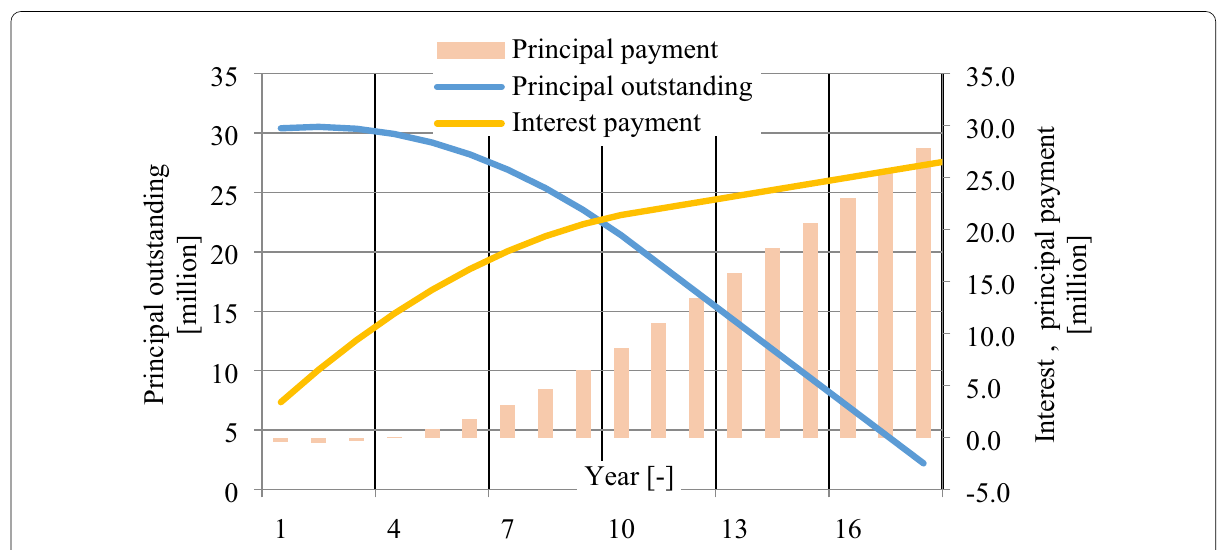
Fig. 4 Payment of debt (principal